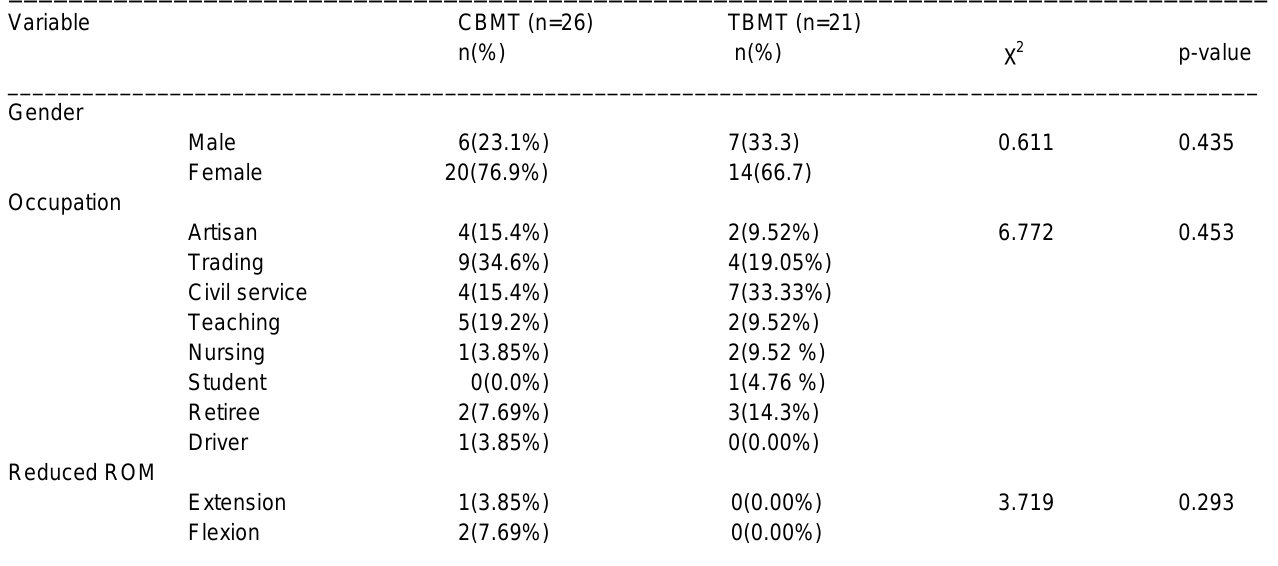
Table 2. Participants’ profile based on the McKenzie Institute Lumbar Spine Assessment